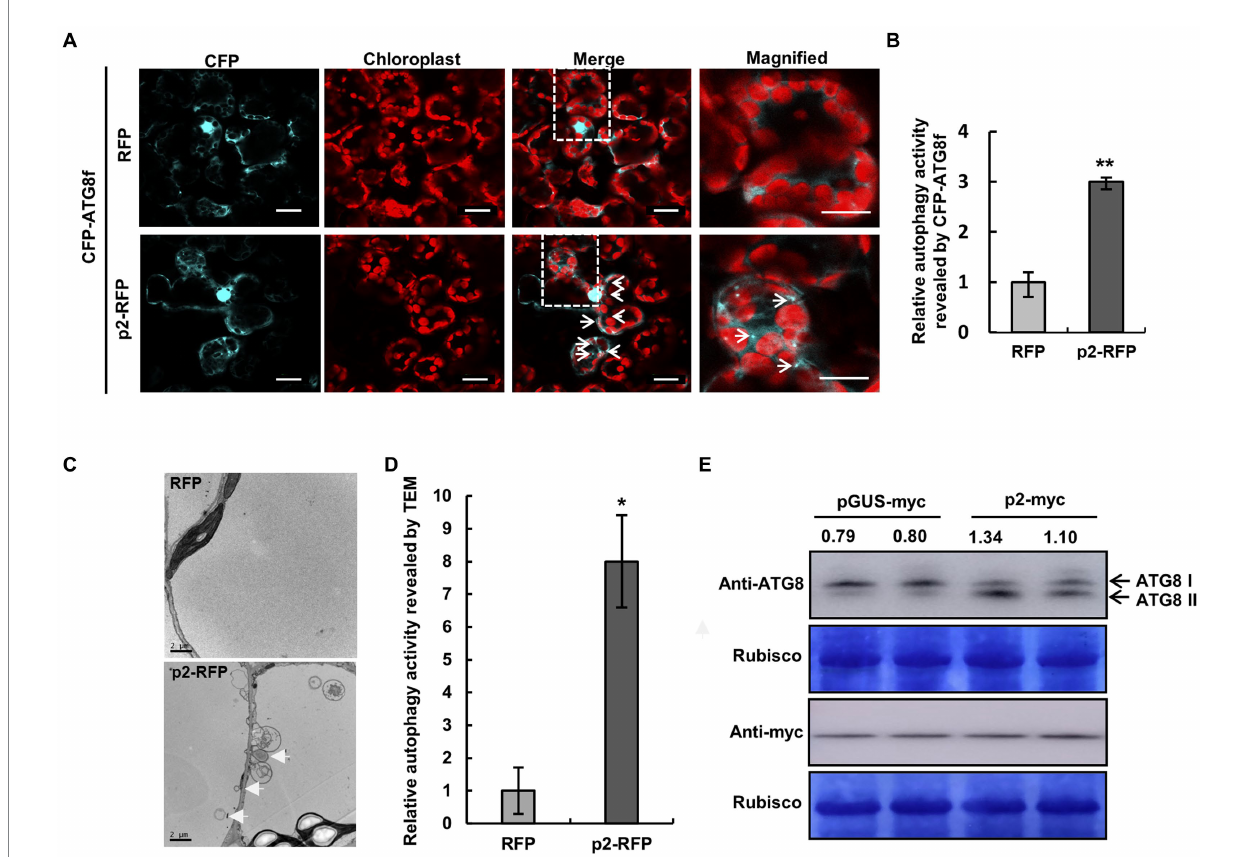
FIGURE 4 Expression of p2 activates autophagy. (A) Representative confocal images of dynamic autophagic activity as revealed by CFP-NbATG8f in control (RFP) and p2-RFP treatments. White arrows show autophagosomes and autophagic bodies labeled by CFP-NbATG8f in cyan in mesophyll cells. Chlorophyll autofluorescence is red. Numerous autophagosomes and autophagic bodies were observed in p2-RFP, but fewer were observed in RFP. Samples were treated with E-64d. Bars, 10 μ m. (B) Quantification of the autophagy activity shown in (A) . Autophagic foci reflected the autophagic activity by CFP-NbATG8f. Relative autophagic activity in cells was normalized to control RFP (which was set to 1.0). Over 150 cells per treatment were used for quantification. Bars indicate standard error from three individual experiments. The asterisks indicate significant difference by Student’s t test (** p < 0.01) compared to the control. (C,D) TEM analysis of N. benthamiana cells inoculated with RFP or p2-RFP (C) . White arrows indicate autophagosomes. Relative autophagic activity in cells normalized to control RFP (which was set to 1.0) (D) . Approximately 20 cells were used to quantify autophagic structures in each treatment. Experiments were repeated three times. Asterisks indicate significant differences by Student’s t-test compared to control inoculation (* p <0.05). (E) Western blotting analysis of type I and type II of NbATG8 in N . benthamiana leaves